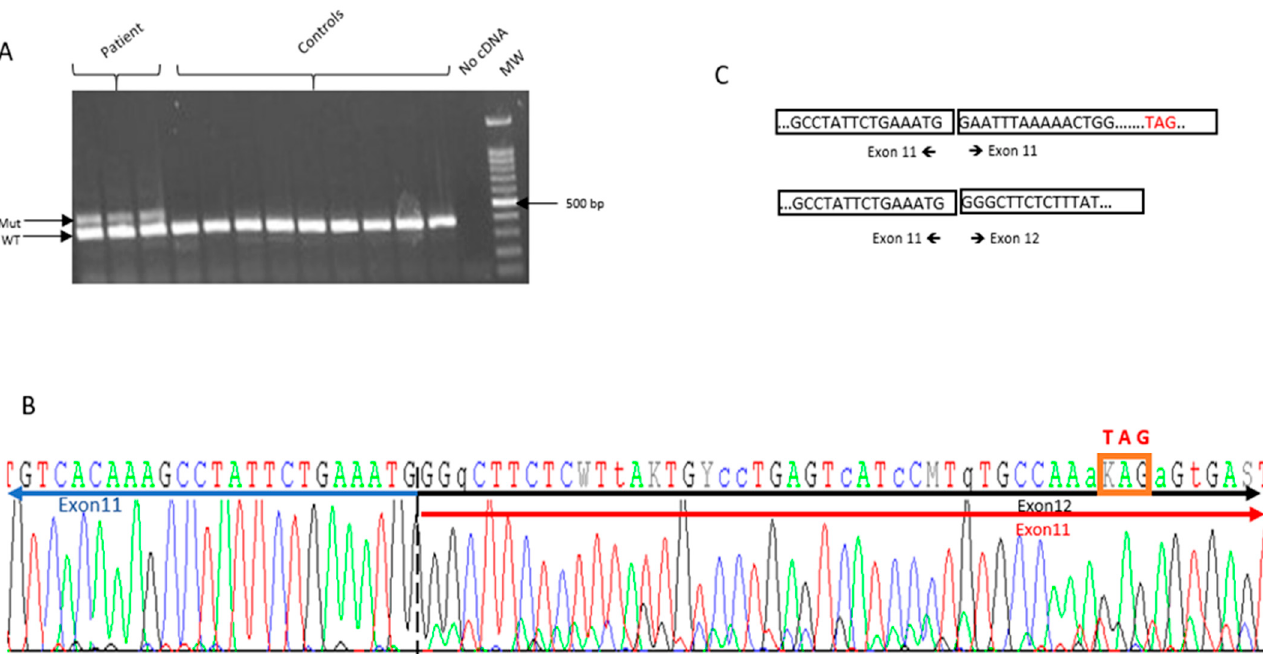
Figure 3. PALB2 Exon 11 duplication disrupts normal splicing and leads to frameshift. ( A ) Agarose gel electrophoresis of the RT-PCR performed with mRNA obtained from the patient and non-carrier controls. An extra band was observed in the patient of about 474 bp, while only the wild-type band was observed in controls (388 bp). ( B ) Sanger sequencing of the two alleles of RT-PCR product of the sample from proband: the insertion leads to a new stop codon as indicated by the red box. ( C ) Schematic representation of the two transcripts observed in the proband sample.